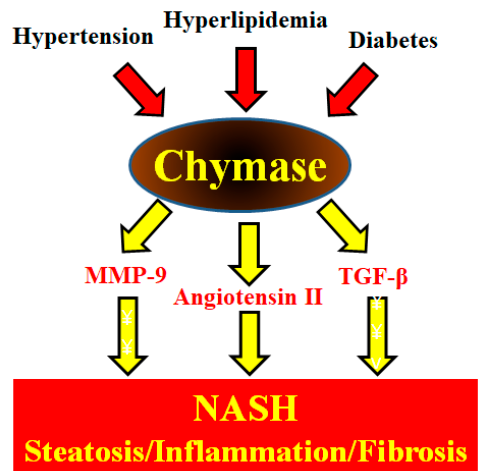
Figure 1. Metabolic syndrome (hypertension, hyperlipidemia, and diabetes) augments hepatic chymase levels. Chymase induces the development and progression of NASH symptoms such as hepatic steatosis, inflammation, and fibrosis via its enzymatic functions.